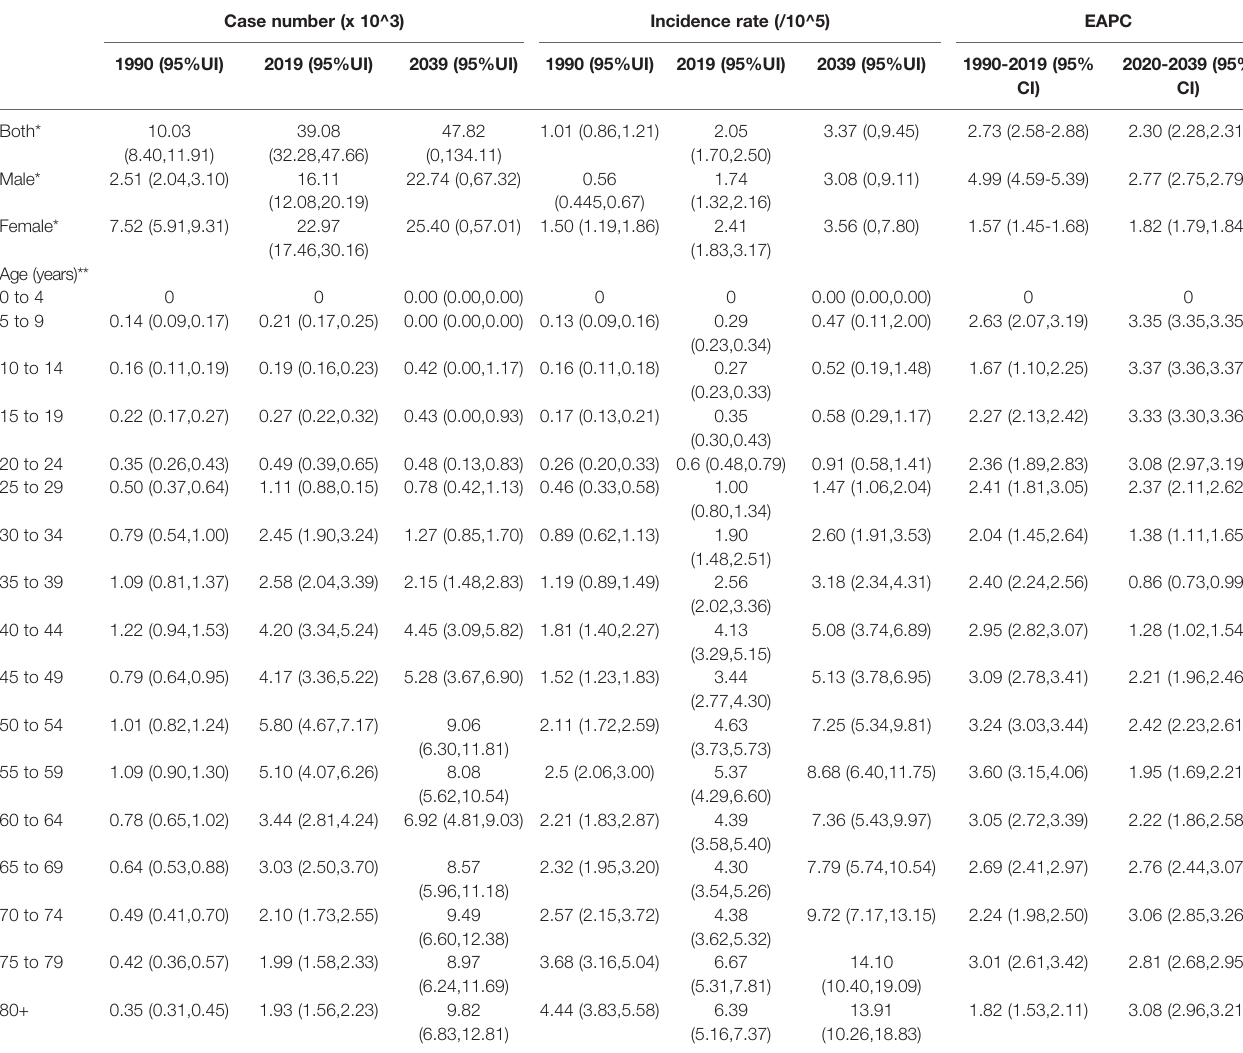
EAPC,estimatedannualpercentagechange;95%UI,95%uncertaintyinterval;95%CI,95%con fi denceinterval;*,age-standardizedofincidencerate;**,crudeincidencerateineachage